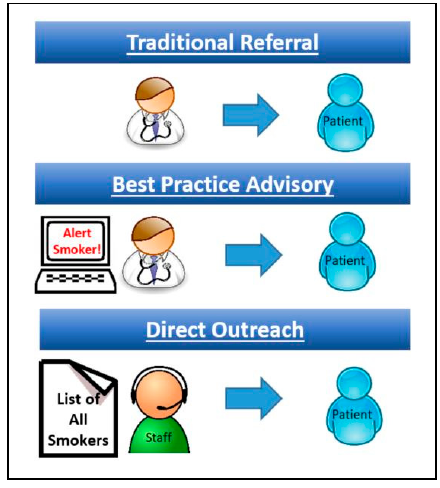
Figure 1. Referral methods.